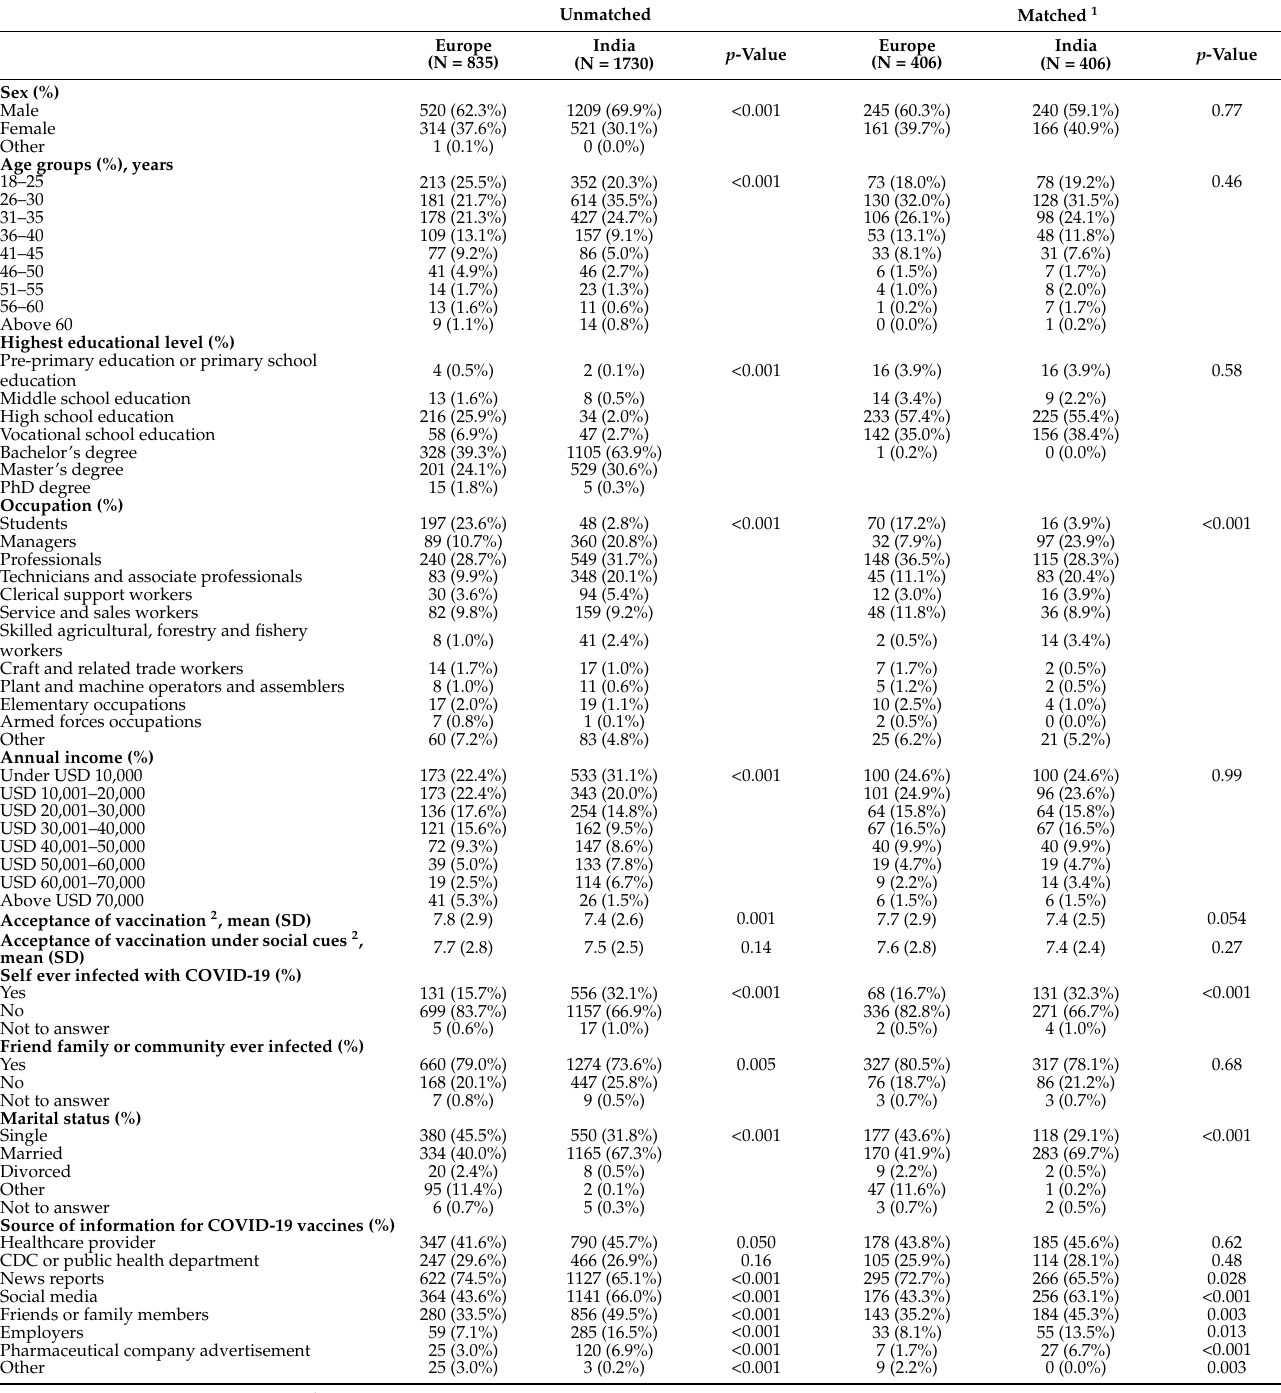
Table 2. Participants’ demographic information, the major source of information, and